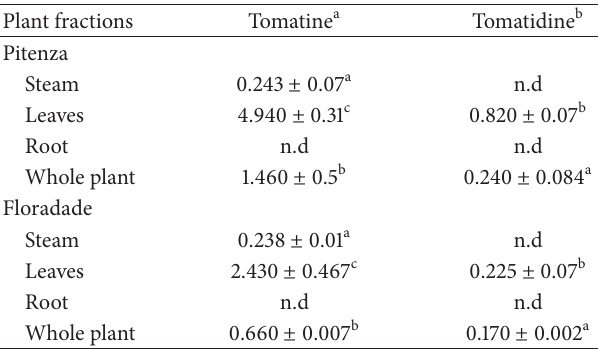
Table 1: Glycoalkaloids composition of tomato plant extracts